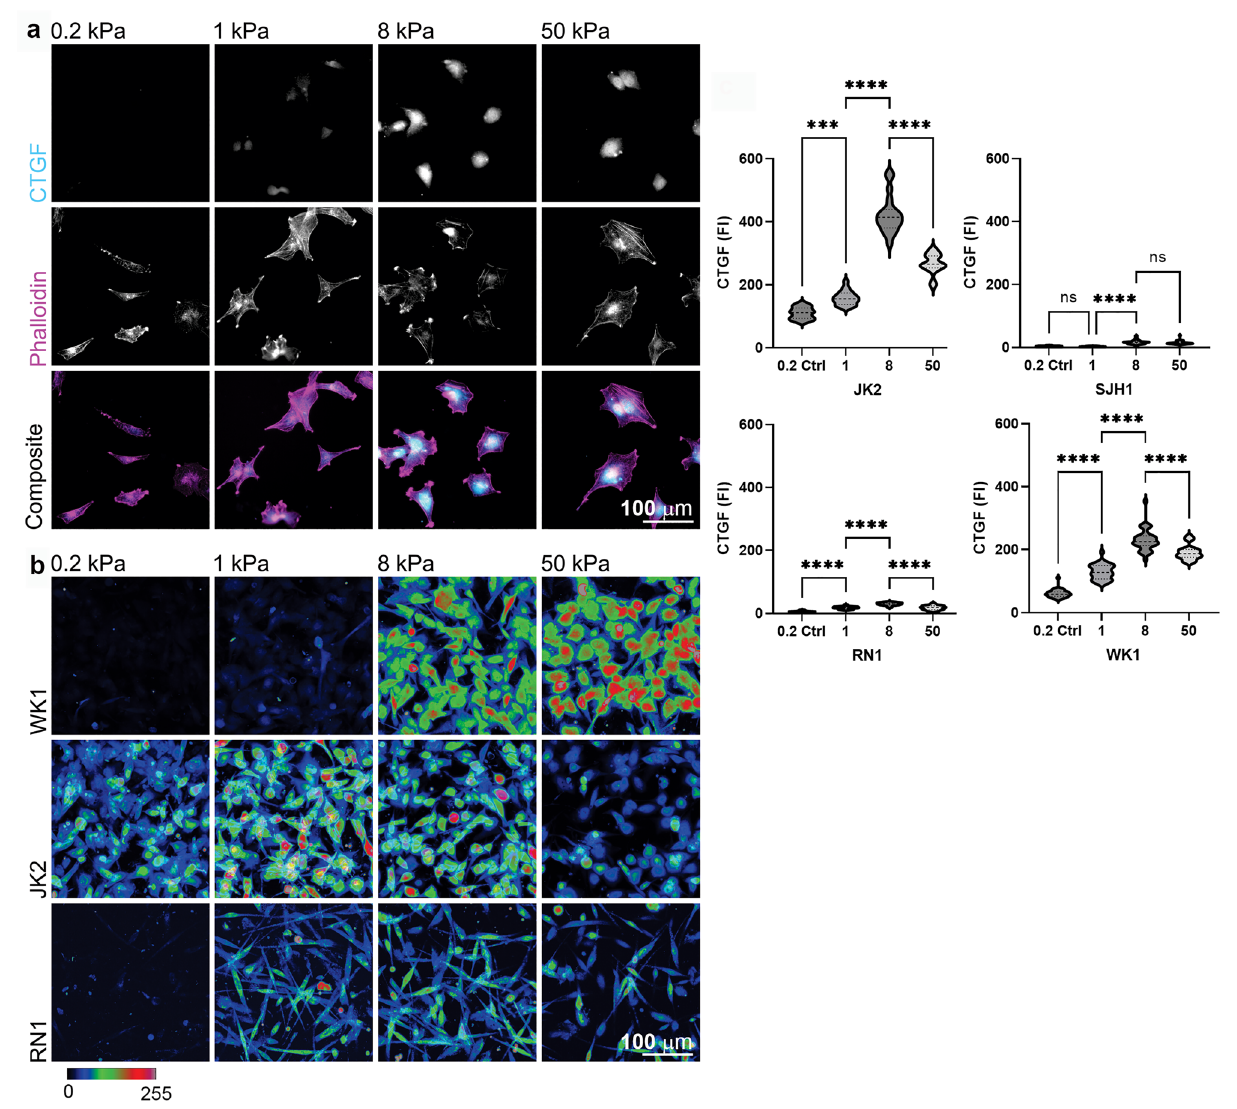
Figure 1. Connective tissue growth factor (CTGF) expression increases with increasing substrate stiffness. ( a ) WK1 cells seeded onto matrix-coupled polyacrylamide (PA) hydrogels (PAGs) of varying stiffness (0.2, 1, 8 or 50 kPa) and immunostained for CTGF. Scale bar 100 µm. ( b ) Colour-coded contrast representations of CTGF immunostaining in WK1, JK2 and RN1 cells grown on matrix-coupled PAGs as indicated. Images show multiple fields of view collapsed into a single image in order to view the CTGF staining across the cell population. Note that the low level of CTGF expression in the SJH1 cells precluded colour-coded representation of this cell line. An example of SJH1 cells immunostained for CTGF expression is instead shown in Supplementary Fig. 2. Image grey values (0–255) represented as varying colour hues as shown. Scale bar 100 µm. ( c ) Graphs show the mean fluorescent intensity of CTGF immunostaining for JK2, SJH1, RN1 and WK1 expressed relative to the cell area. Cells were segmented based upon F-actin counterstaining. Data were pooled from 16 regions of interest per cell line, per condition. Symbols denote statistical significance: ****p < 0.0001; ***p < 0.001; N = not significant (p > 0.05); One-way ANOVA with Tukey’s post-comparison test. Error bars indicate even further and was unchanged in JK2 cells that had been replated onto 0.2 kPa PAGs. Collectively, these data suggest that increased CTGF is a consequence of cell growth on the rigid 50 kPa substrate environment. Mechanosensitive CTGF expression precedes actin filament organization. To investigate the specific role of actin stress fibres in this stiffness-mediated effect on CTGF expression, cells were treated with the actin-depolymerising compound Latrunculin A (Lat A). Soluble/insoluble fractions extracted from cells grown on plastic dishes were first visualised and analysed via Western Blot and densitometry, respectively to determine the concentration of Lat A required (Fig. 4a). This revealed a dose dependent increase in the soluble fraction with increasing Lat A concentration, as expected (Fig. 4a), with 0.5 µM Lat A resulting in significantly increased